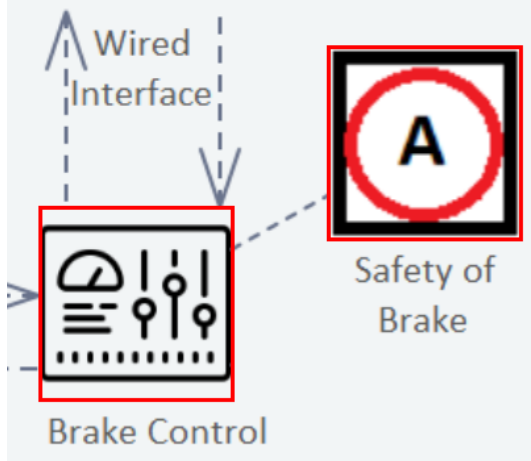
Figure 16. Threat regarding brake control.